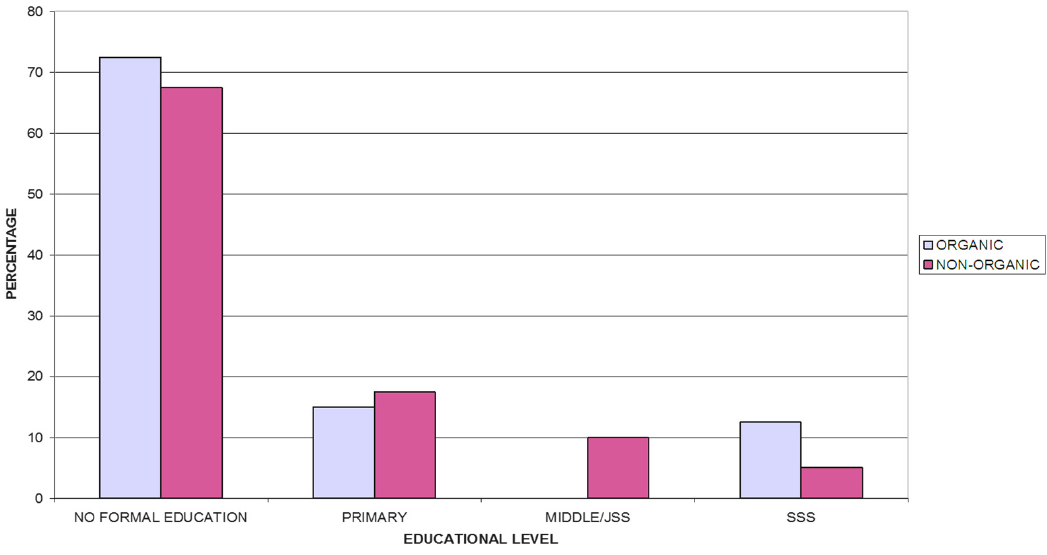
Figure 3. Educational status of respondents